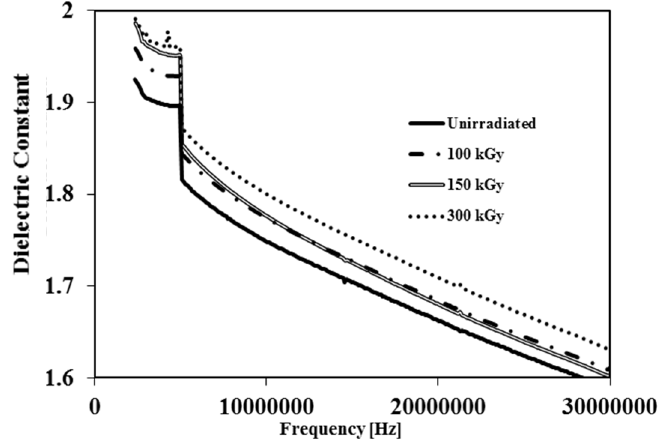
Figure 5. Dielectric constant vs. frequency of unirradiated and irradiated PVDF membranes by 100 kGy, 150 kGy and 300 kGy.